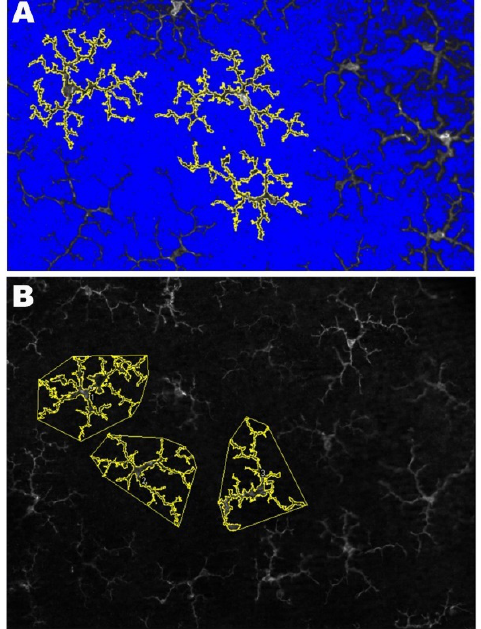
Figure 8. Methodology for the quantification of the microglial cells. ( A ) The photomicrograph shows the results of processing with the Image J program to analyze of the area occupied by each microglial cell. ( B ) The photomicrograph illustrates the method used for the quantification of the arbor area using the Image J program. By using the polygon tool, the most distal tips of the microglial processes were